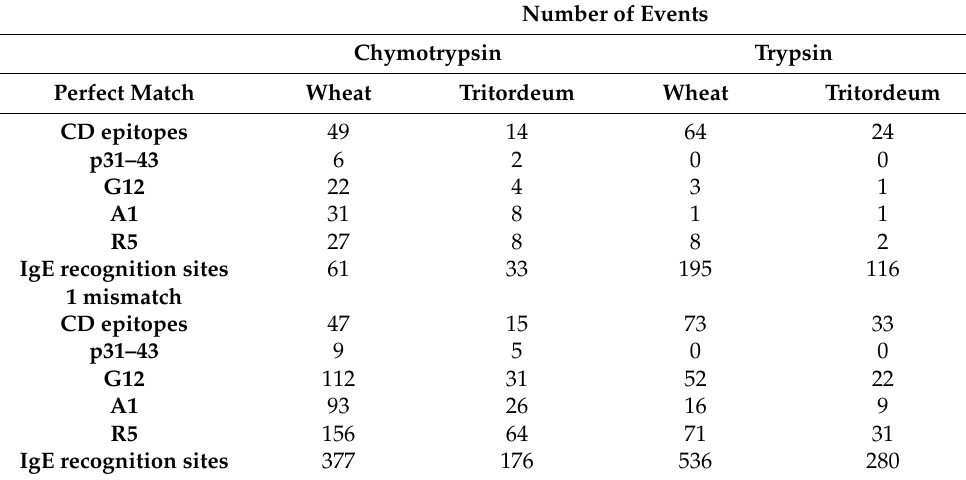
Table 1. Number of events with perfect match or one mismatch of CD immunogenic epitopes, recognition sites of monoclonal antibodies, and IgE binding sites in unique peptides 1 of different types of flour from wheat and Tritordeum by two digestion enzymes. Number of Events Chymotrypsin Trypsin Perfect Match Wheat Tritordeum Wheat Tritordeum CD epitopes